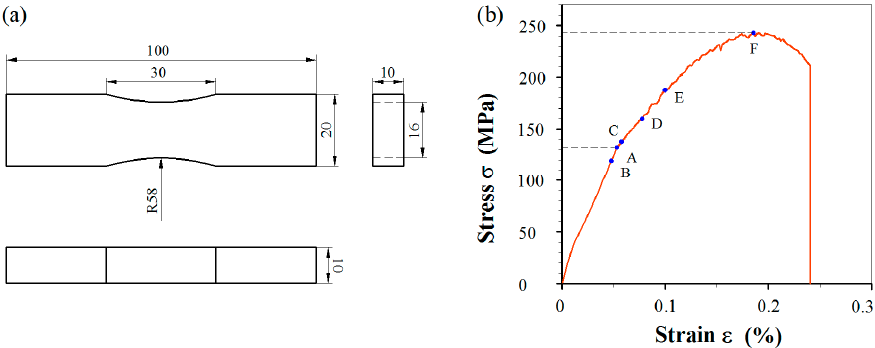
Figure 1. ( a ) The geometry and detailed dimensions of the Al-alloy specimen for measuring the stress– strain curve (in mm); and ( b ) the experimental result. Table 2. The pre-stresses applied to Extended-compact tension (E-CT) samples for fatigue